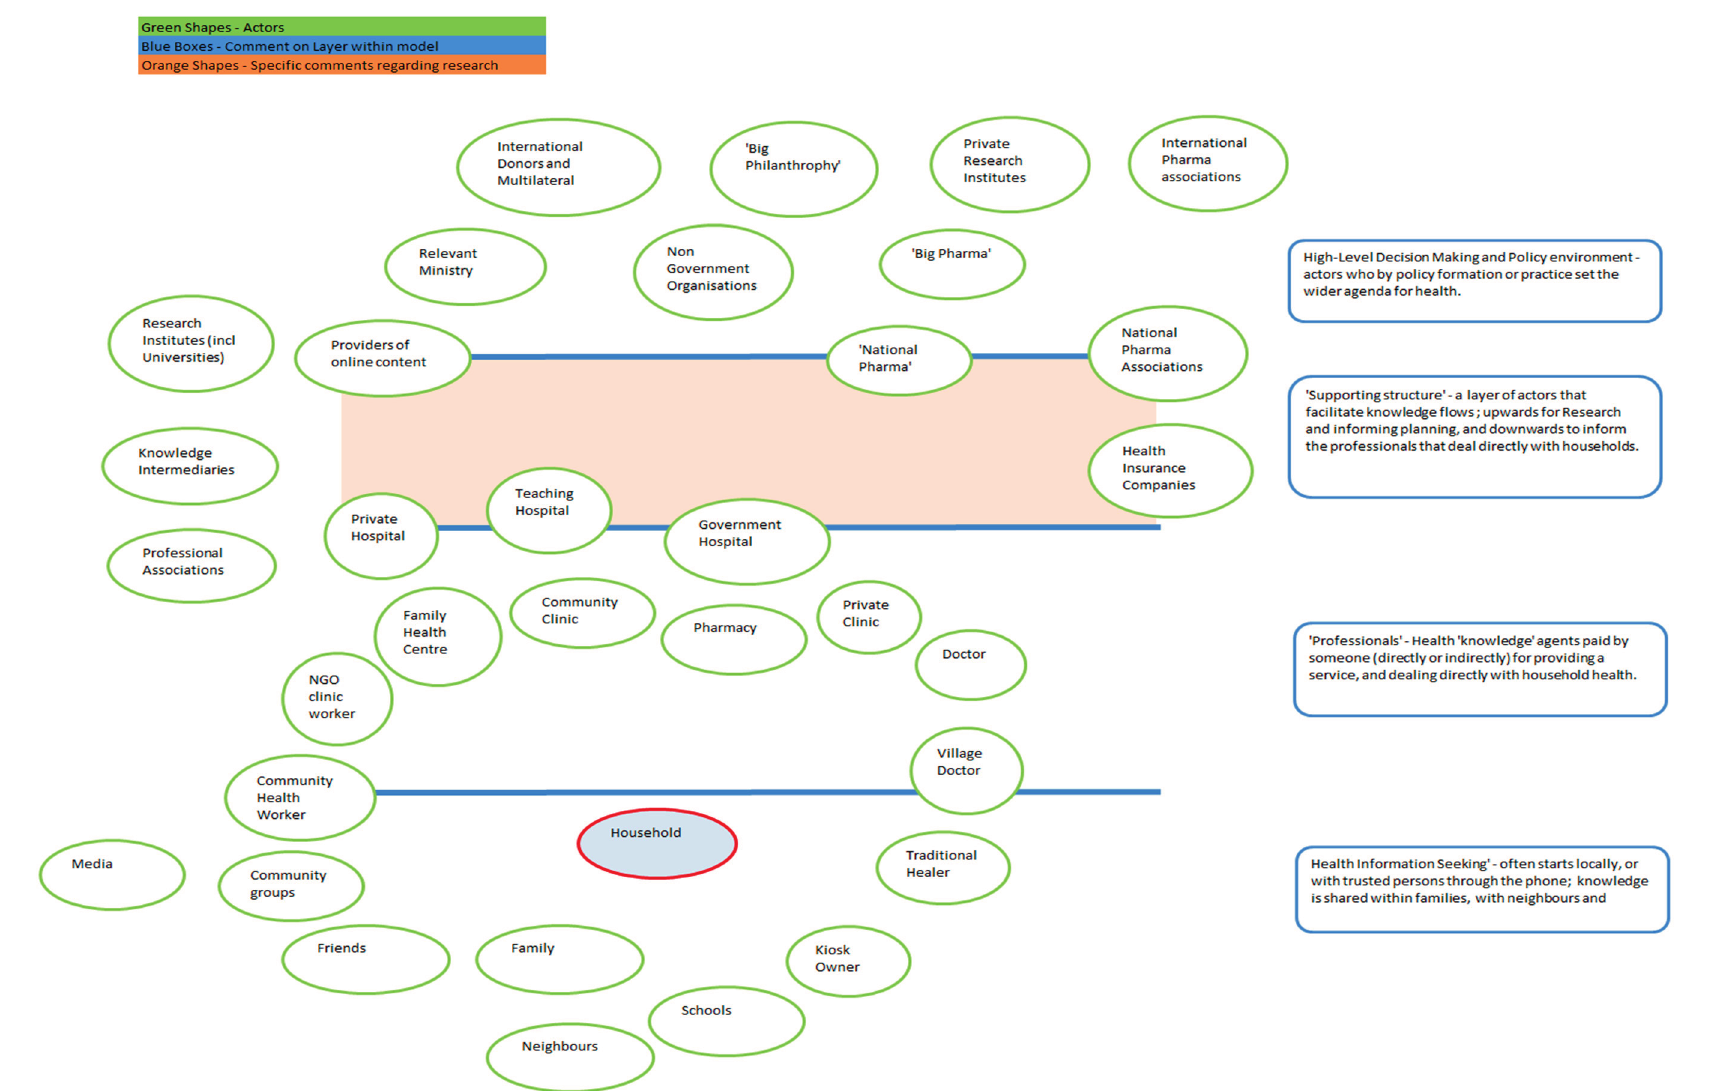
Figure 1. The different types of actors represented in the Bangladesh health